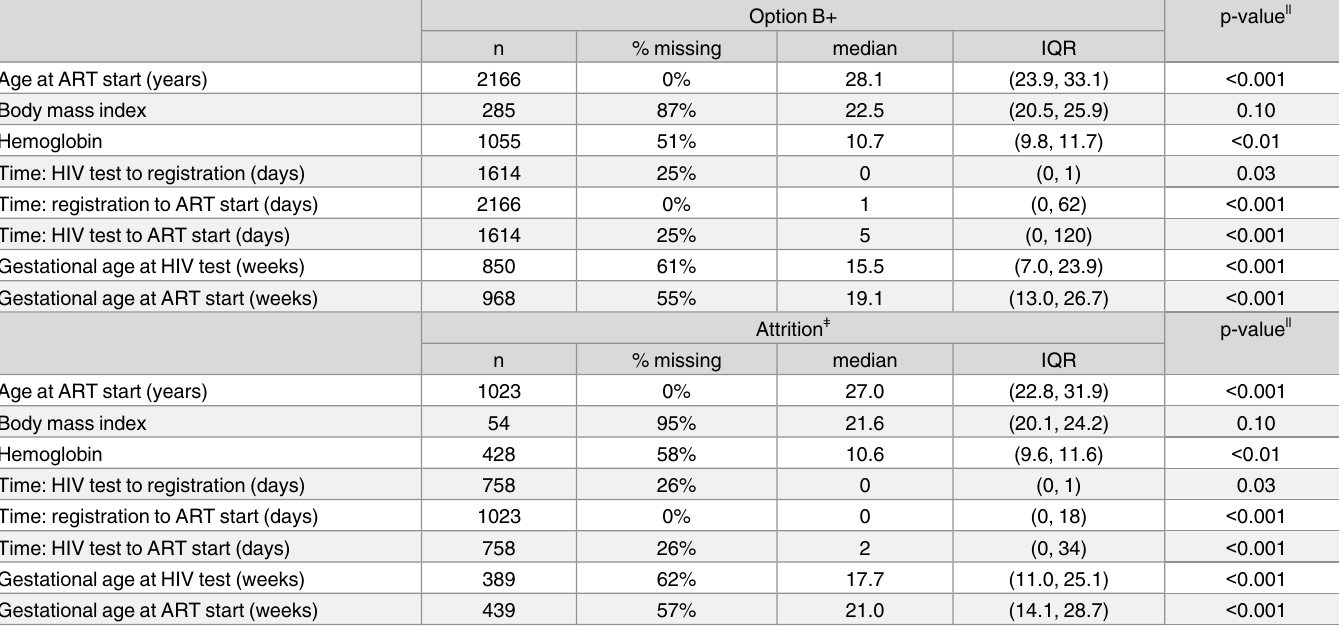
Table 2. Characteristics of Option B+ patients (Continuous